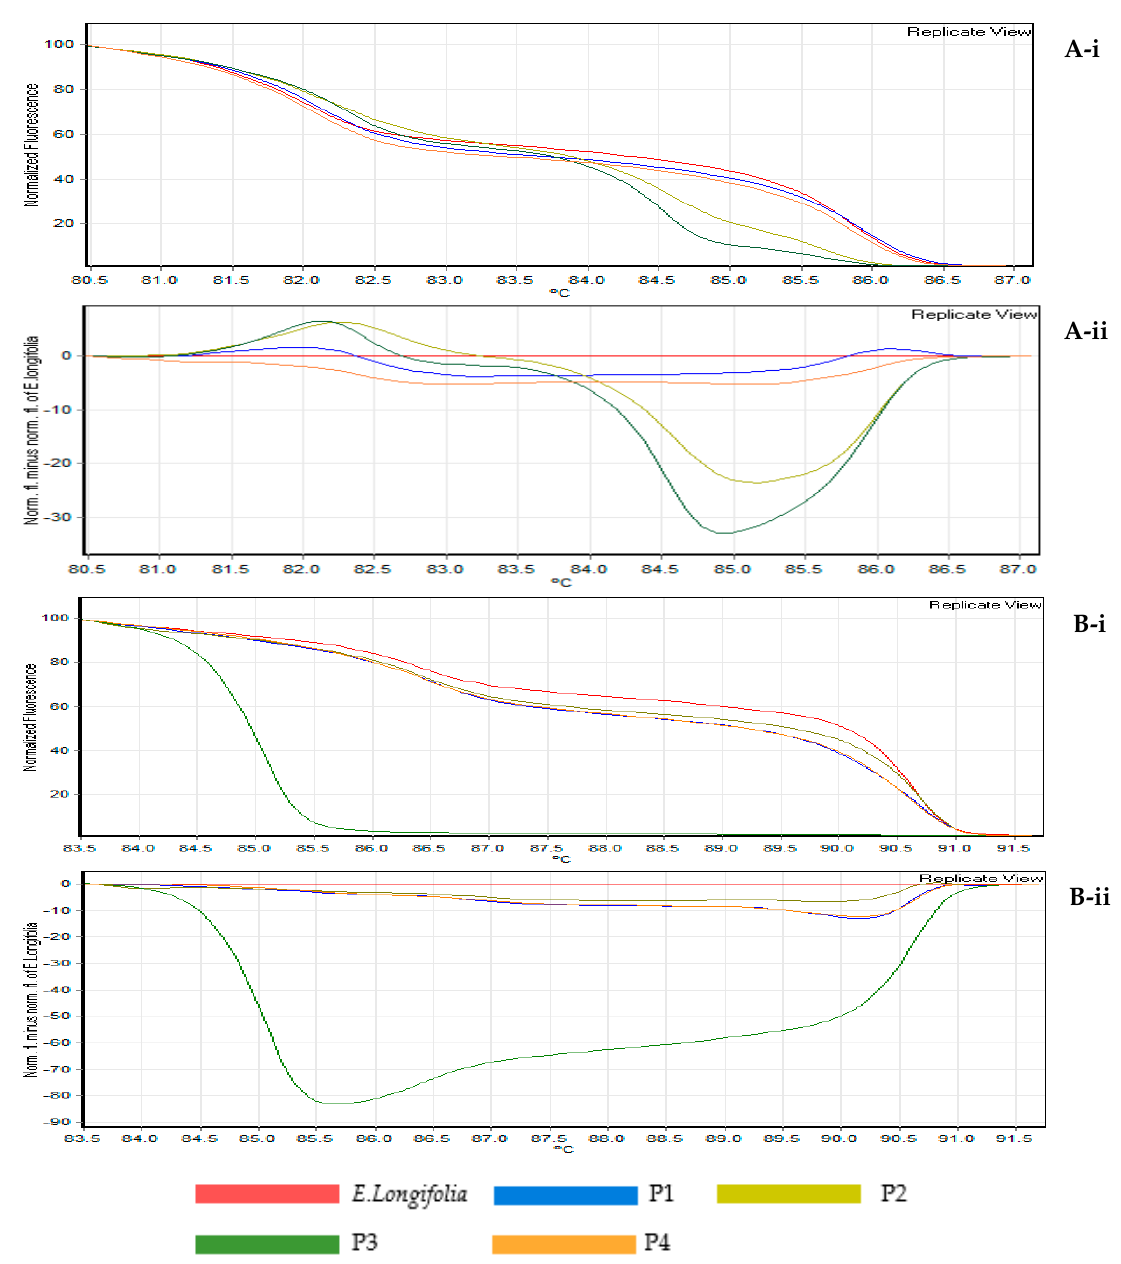
Figure 1. HRM analysis on real time PCR amplicon targeting rbcL ( A-i ) normalised rbcL curves, ( A-ii ) rbcL difference curves; and ITS2 ( B-i ) normalised ITS2 curves, ( B-ii ) ITS2 difference curves.